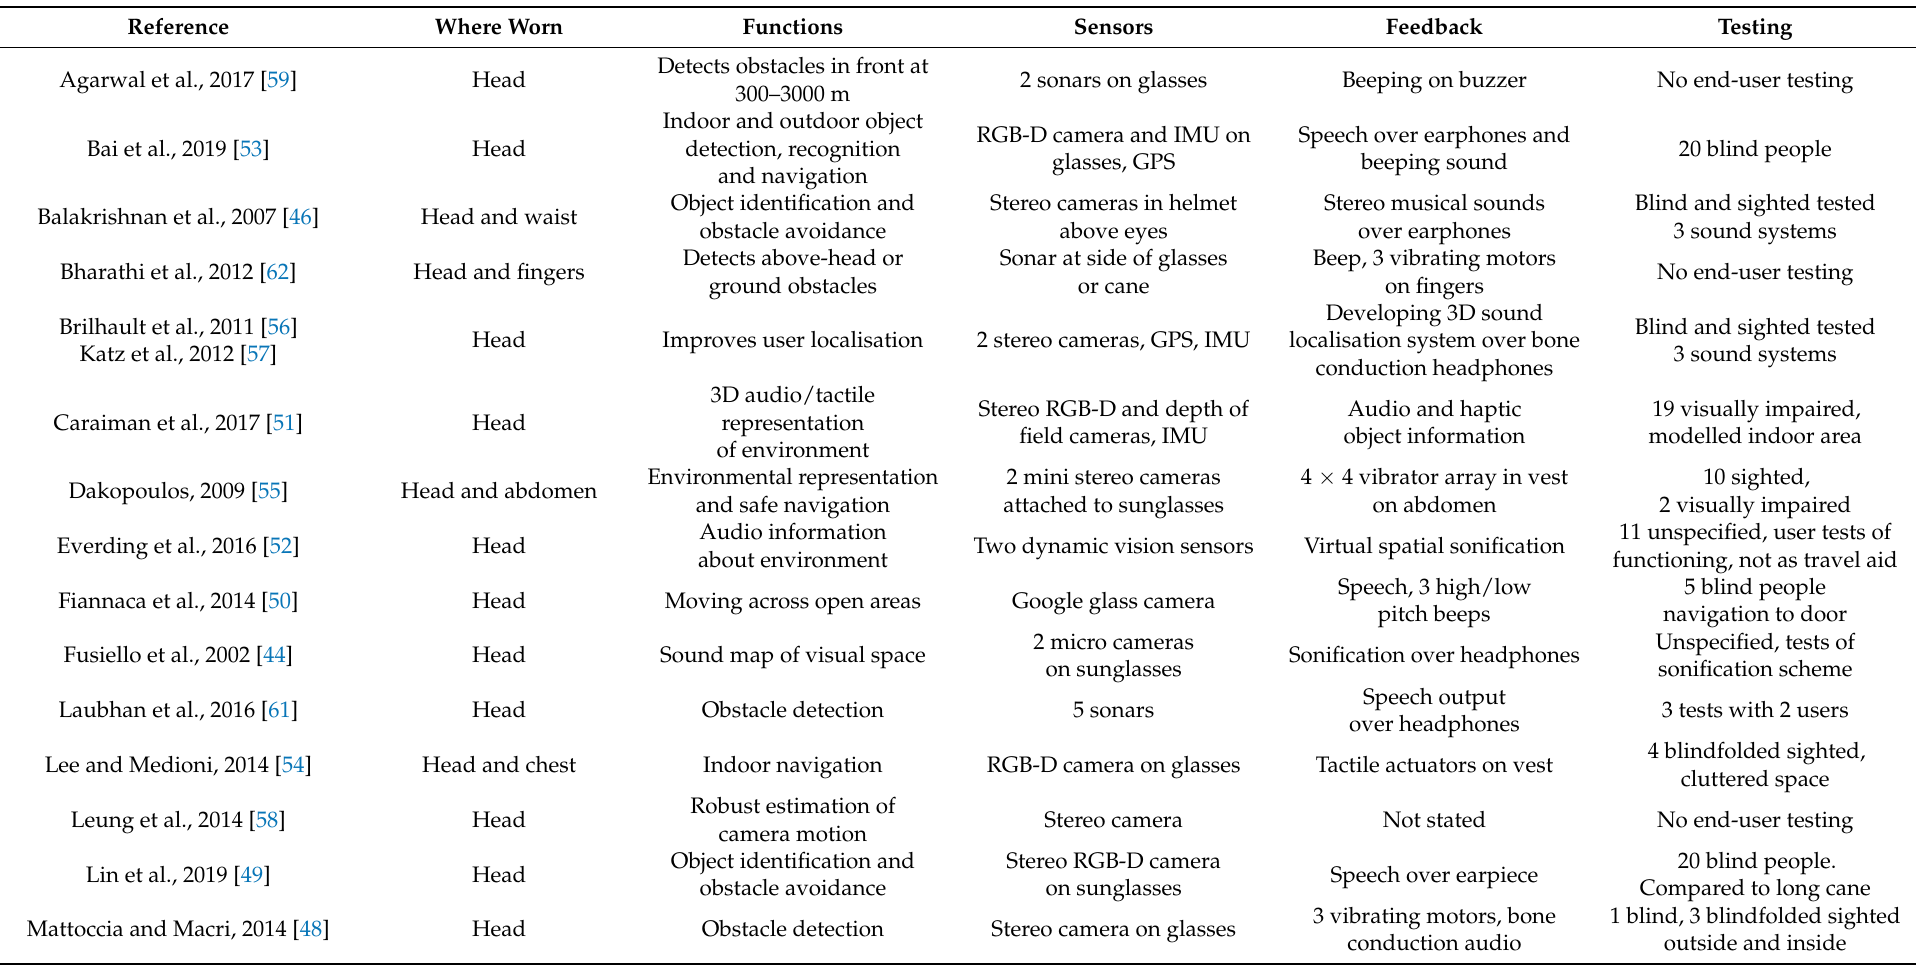
Table 2. Device features and testing for head-mounted